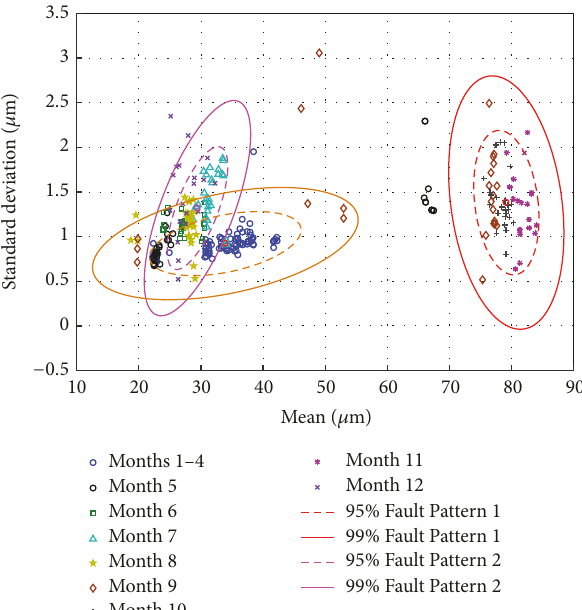
Figure 12: [CS2] Novelty detection and fault pattern location based on GMMOC (months